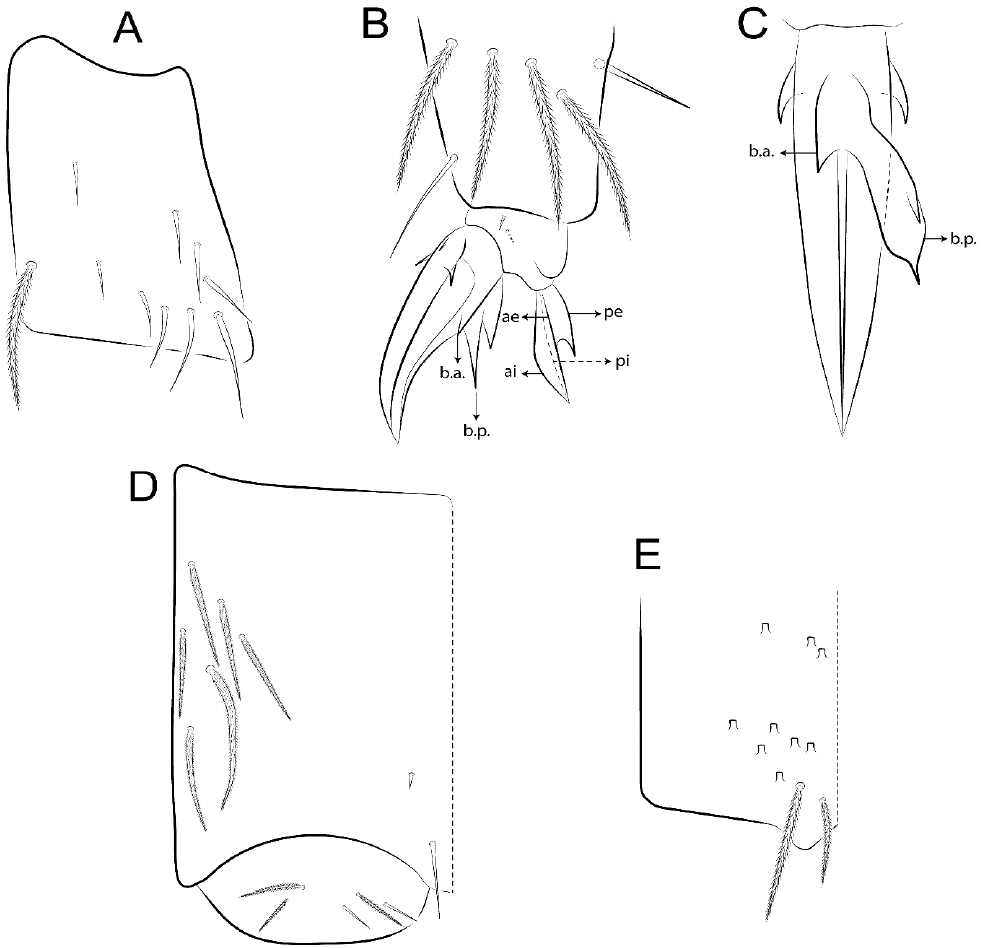
Figure 21. Pseudosinella labiociliata sp. nov.: trunk appendages. ( A ) trochanteral organ; ( B ) distal tibiotarsus and empodial complex III (anterior view); ( C ) unguis (inner view); ( D ) collophore (lateral view); ( E ) distal part of manubrium (ventral view).